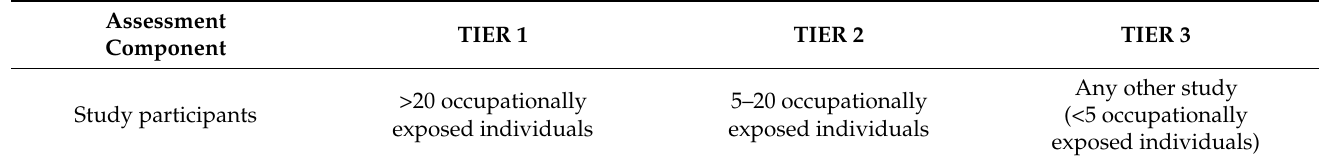
Table 3. Adaptation of LaKind scoring method to HBM studies concerning